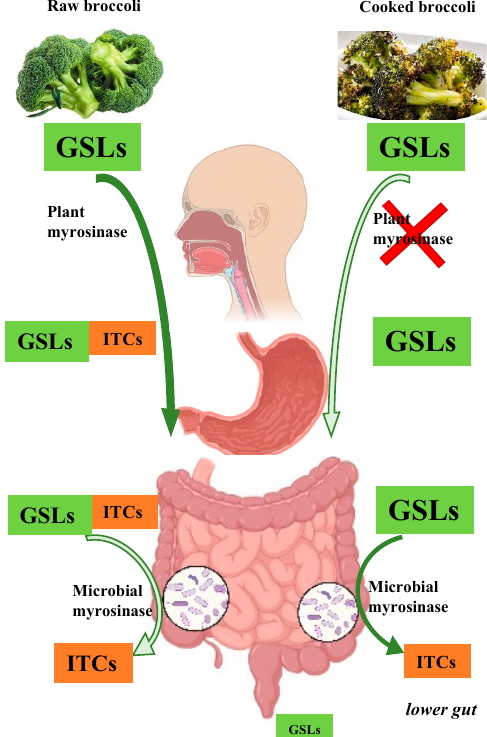
Figure 1. Metabolic fate of glucosinolates in raw vs. cooked broccoli. GSLs, glucosinolates; ITCs, isothiocyanates. Figure created with BioRender.com.